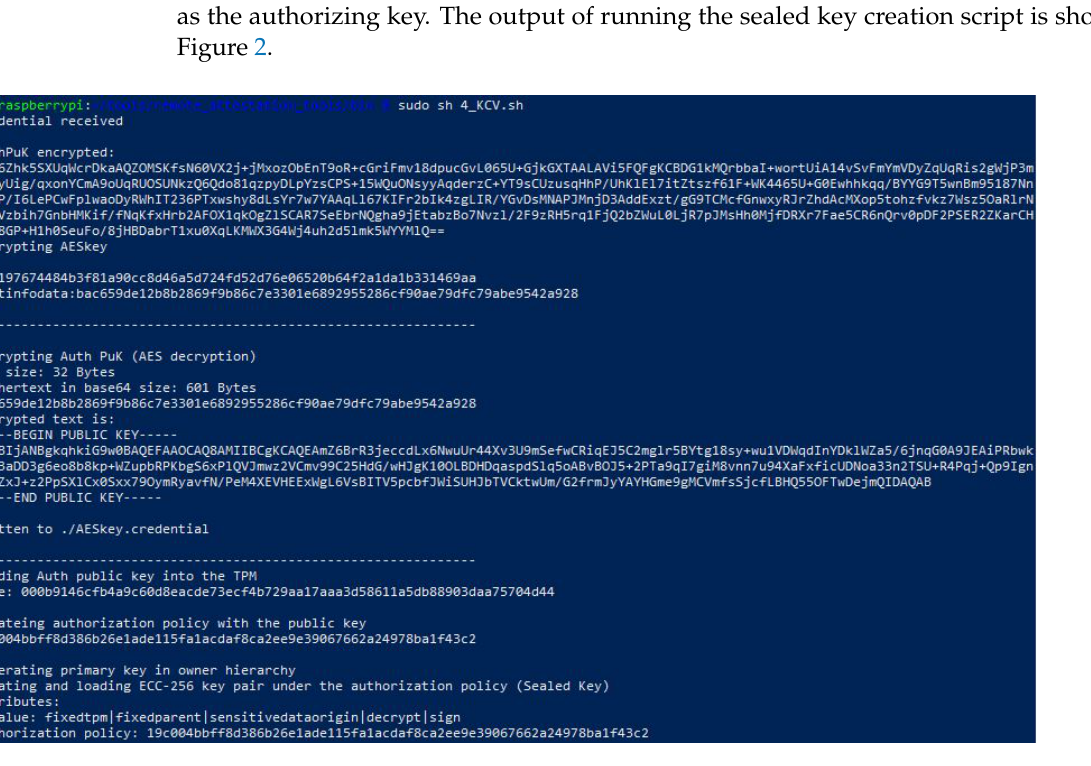
Figure 2. Output of the script for sealed key